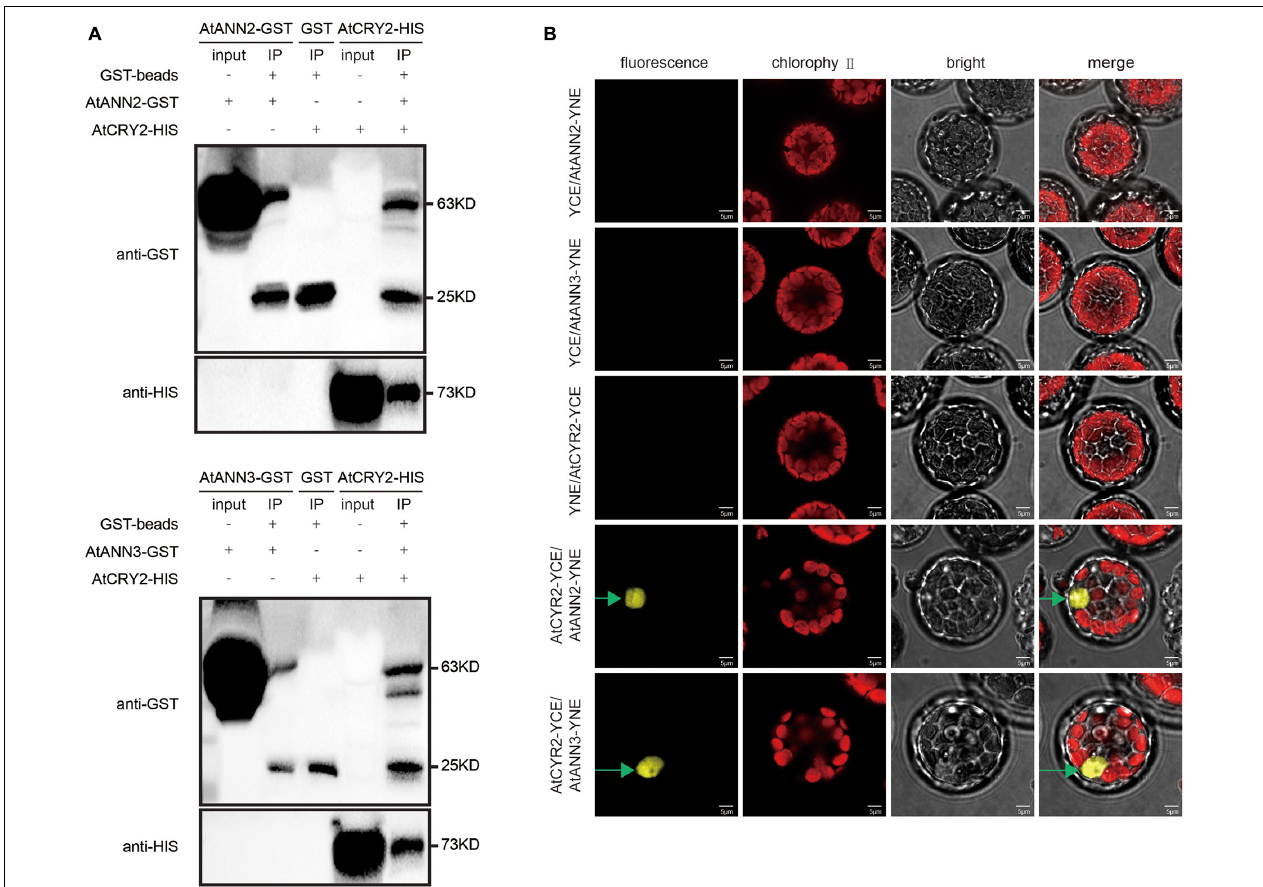
FIGURE 6 | AtCRY2 interacts with AtANN2 and AtANN3 proteins. (A) GST pull-down assay. AtANN2-GST, AtANN3-GST, GST, and AtCRY2-HIS proteins were expressed in Escherichia coli . Purified proteins were used for the pull-down assay. Proteins immunoprecipitated were analyzed with anti-GST antibodies or anti-HIS antibodies. (B) Bimolecular fluorescence complementation (BiFC) assay: The C-terminal domain of YFP fused to AtCRY2 was coexpressed (AtCRY2-YCE) with a fusion protein of the N-terminal domain of YFP and AtANN2 or AtANN3 (AtANN2-YNE or AtANN3-YNE). YNE or YCE vectors expressing split YFP domains alone were used as controls. The constructs were co-injected into Arabidopsis leaf cells, and the YFP signals were observed after 48–72 h in transiently transformed protoplasts by fluorescence microscopy. Scale bar = 5 µ m.